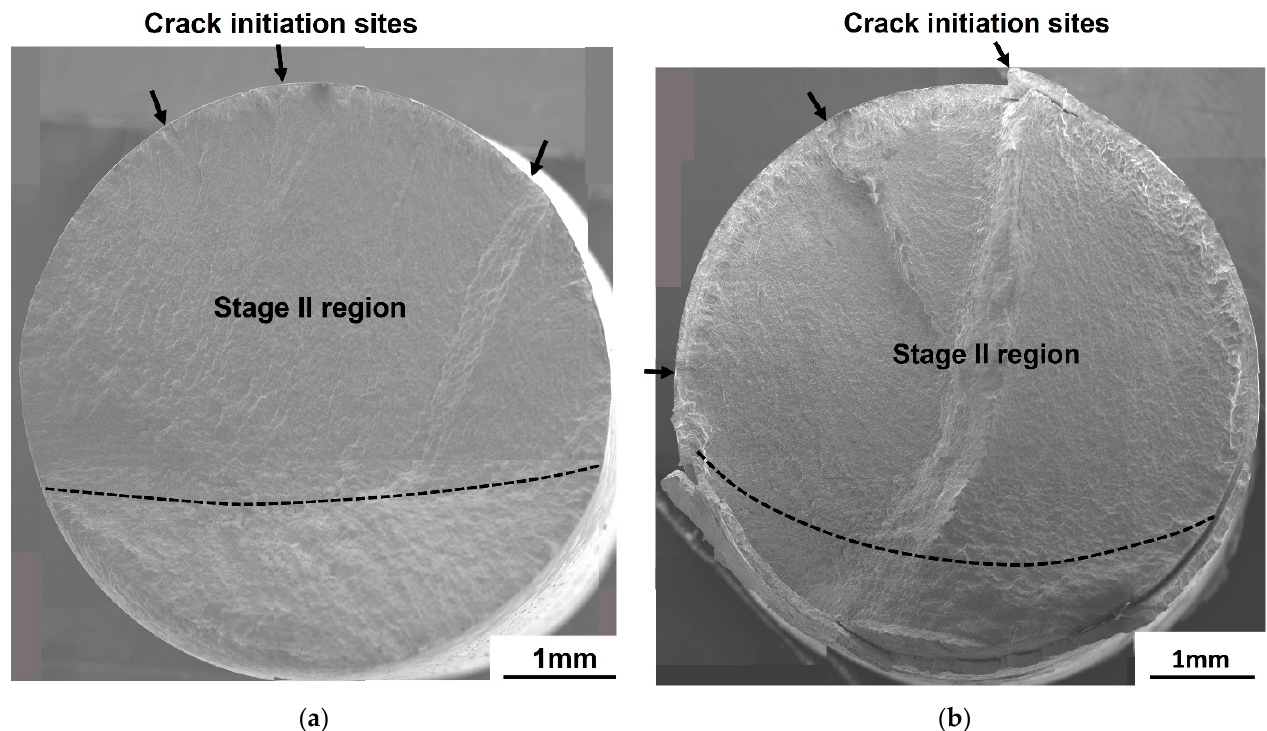
Figure 9. Fatigue fracture surfaces of normalized AISI 1020 steel in the high cycle fatigue at R = − 1.0: ( a ) non-galvanized, σ max = 149.8 MPa and ( b ) galvanized, σ max = 138.5 MPa.